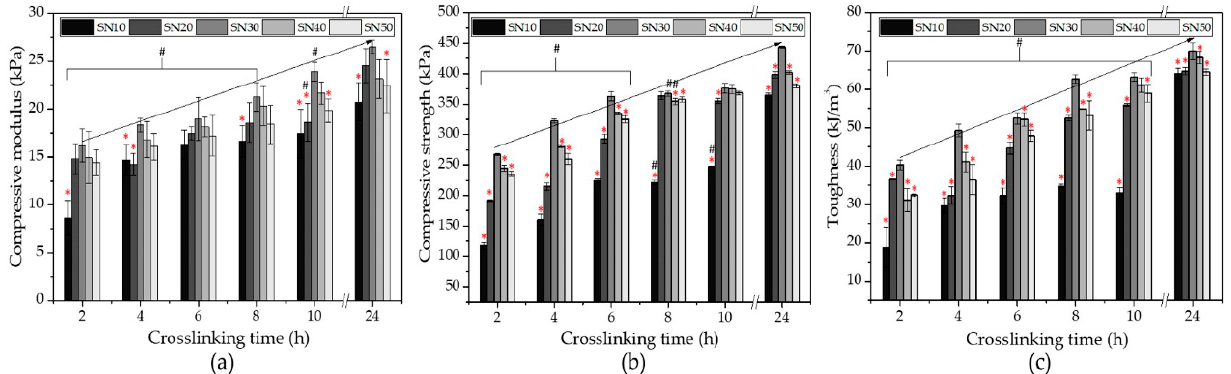
Figure 7. Compressive properties of SN starch hydrogels prepared with various crosslinker (GA) contents; ( a ) compressive modulus, ( b ) compressive strength and ( c ) toughness ( n = 5 , * p < 0.05 compared with SN30and # p < 0.05 compared with 24 h of crosslinking time).